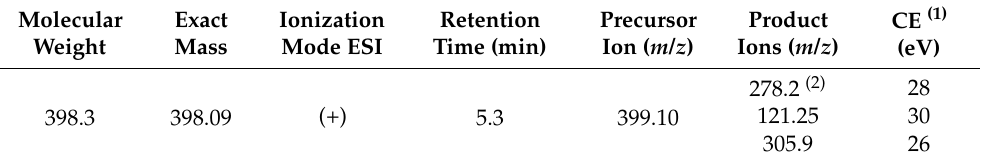
Table 1. LC-MS/MS parameters for